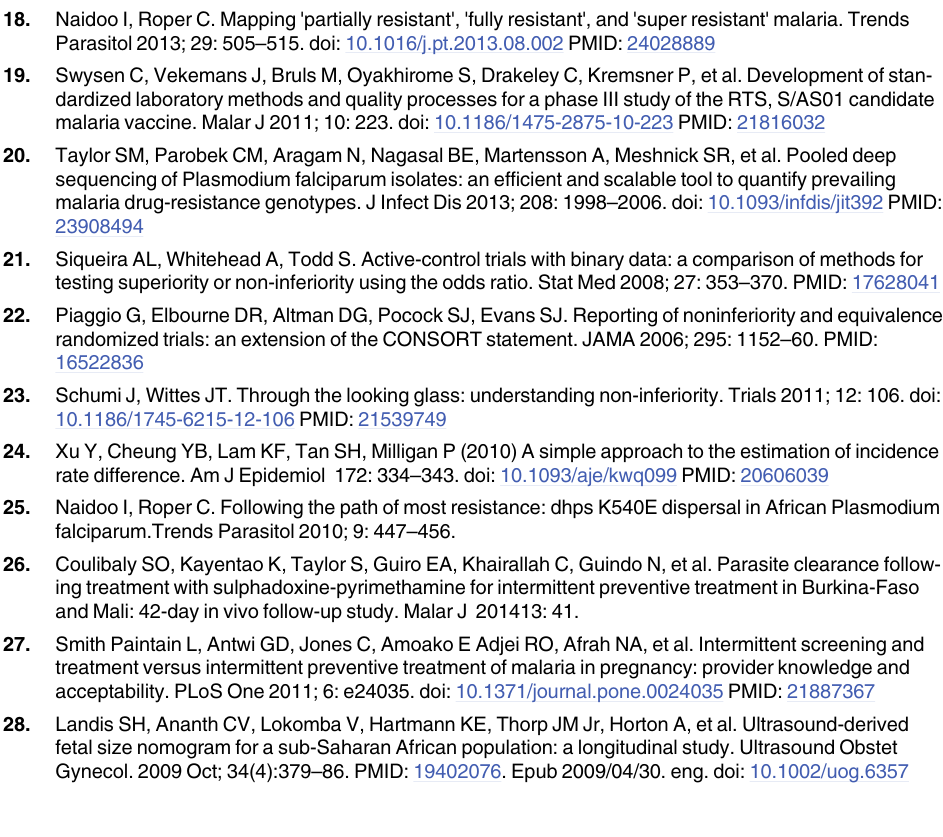
PLOS ONE | DOI:10.1371/journal.pone.0132247 August 10,